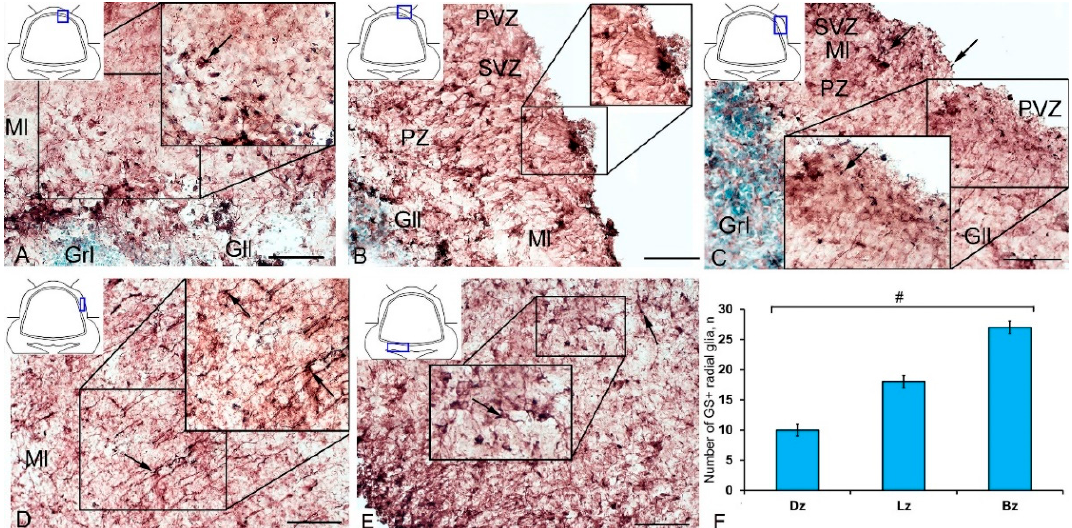
Figure 9. Distribution of GS+ cells in the intact cerebellum of juvenile masu salmon, Oncorhynchus masou , and after injury. ( A ) Number of type 1 GS+ cells. ( B ) Number of type 2 GS+ cells. ( n = 5 in each group; * p ≤ 0.05 is a significant difference vs. control groups). Student–Newman–Keuls test. The X- axis indicates the cerebellar area. DZ, dorsal zone; LZ, lateral zone; BZ, basal zone; Ml, molecular layer; Grl, granular layer; Gll, ganglionic layer.